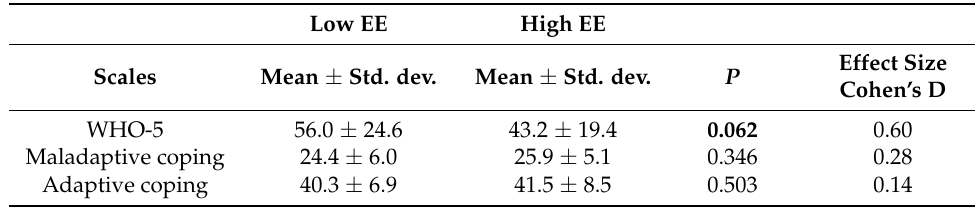
Table 2. World Health Organization Well-Being Index (WHO-5) and Brief COPE based on the relatives’ level of expressed emotion (EE) (N = 48).